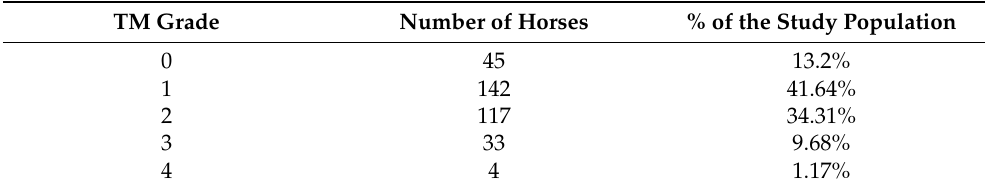
Table 5. Frequency and grade distribution of tracheal mucus accumulation (TM) among the study